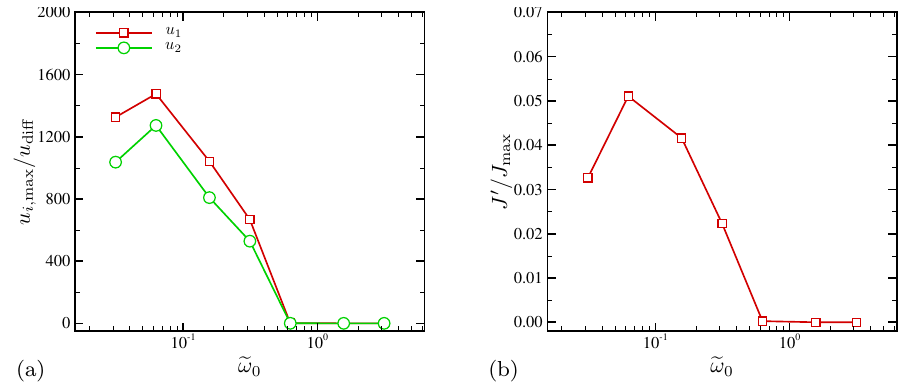
Figure 16. ( a ) Normalized maximum velocities and ( b ) normalized current density fluctuations in the transverse direction. In ( b ), J max is obtained by taking the maximum of surface current density averaged in the x 1